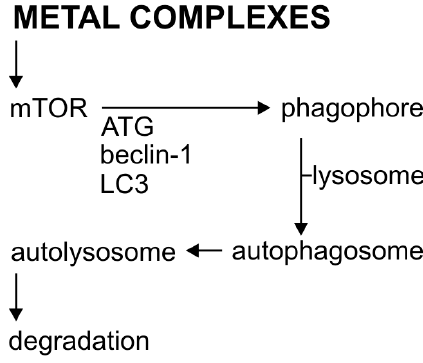
Figure 2. The process of autophagy and its activation by metal complexes.